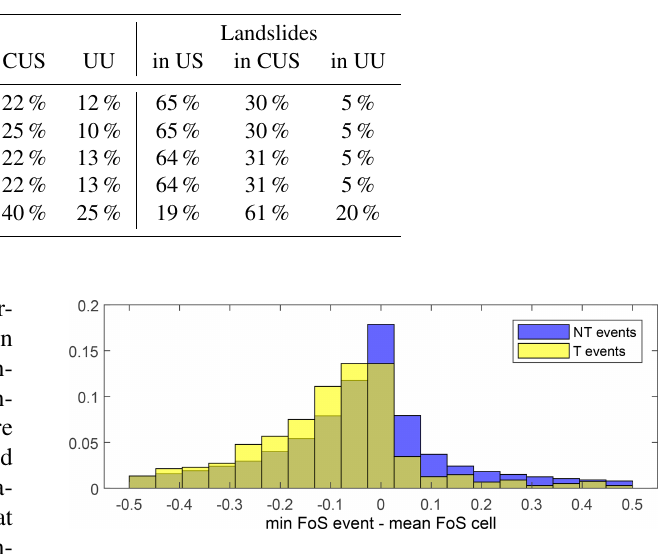
Figure 4. Histograms of the departures of the minimum factor of safety from its grid-based long-term mean during landslide trigger- ing (T) and non-triggering (NT) rainfall events, combining spatial (i.e. differences between landslide locations) and temporal (i.e. dif- ferences between events in the cells)